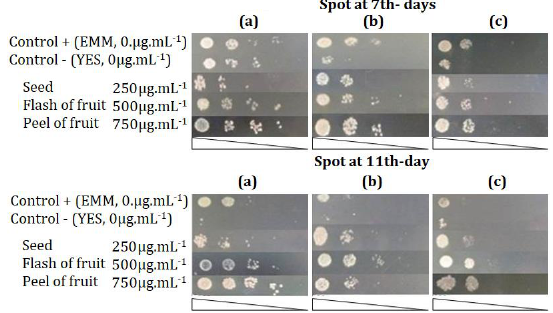
Figure 5. Effect of phytoextracts derived from the generative organ parts of X. granatum on the viability of S.pombe cells against oxidative